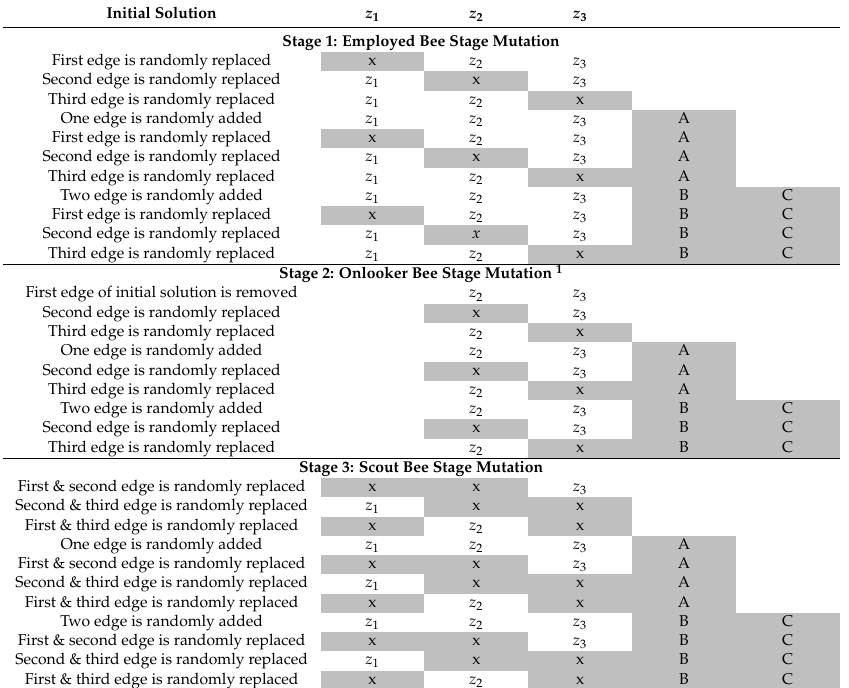
Table 1. Discrete ABC mutation